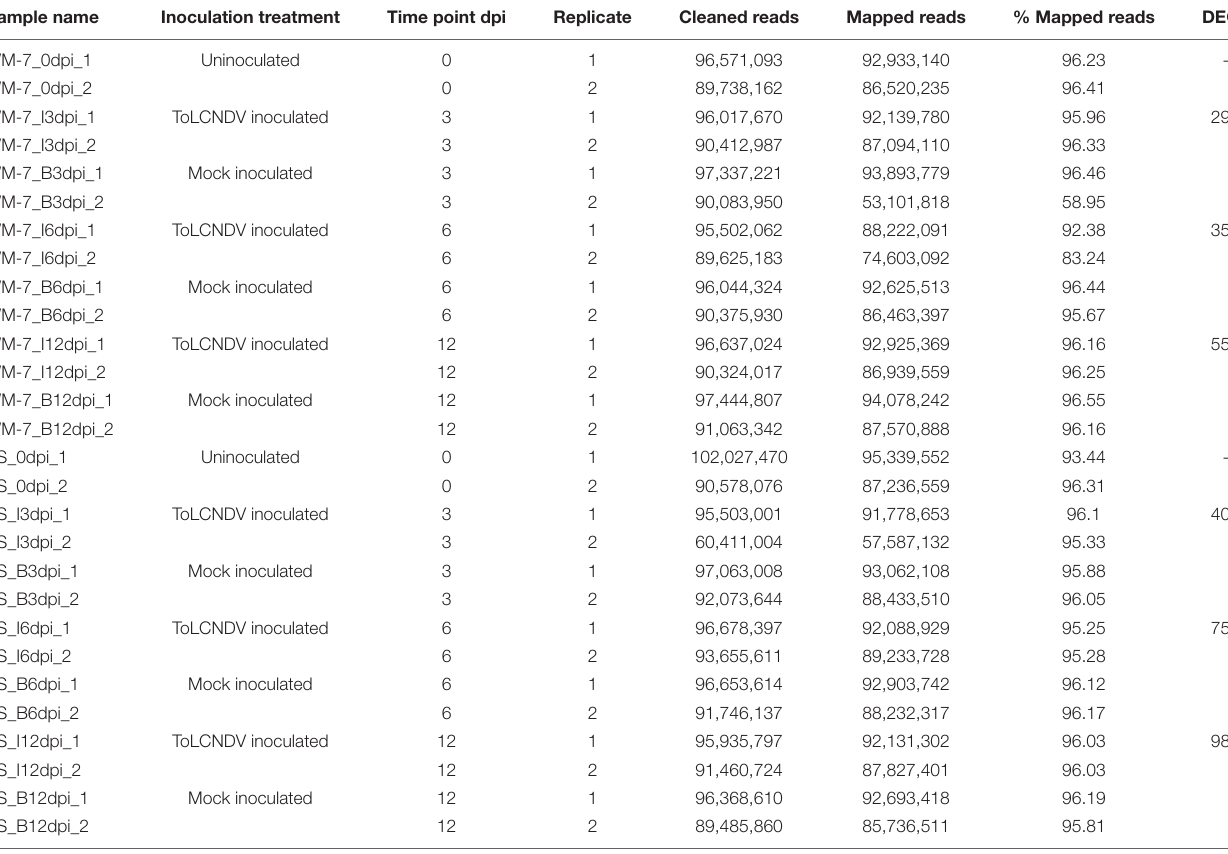
TABLE 1 | Summary of the RNA-Seq experimental design, read alignment, and differentially expressed genes